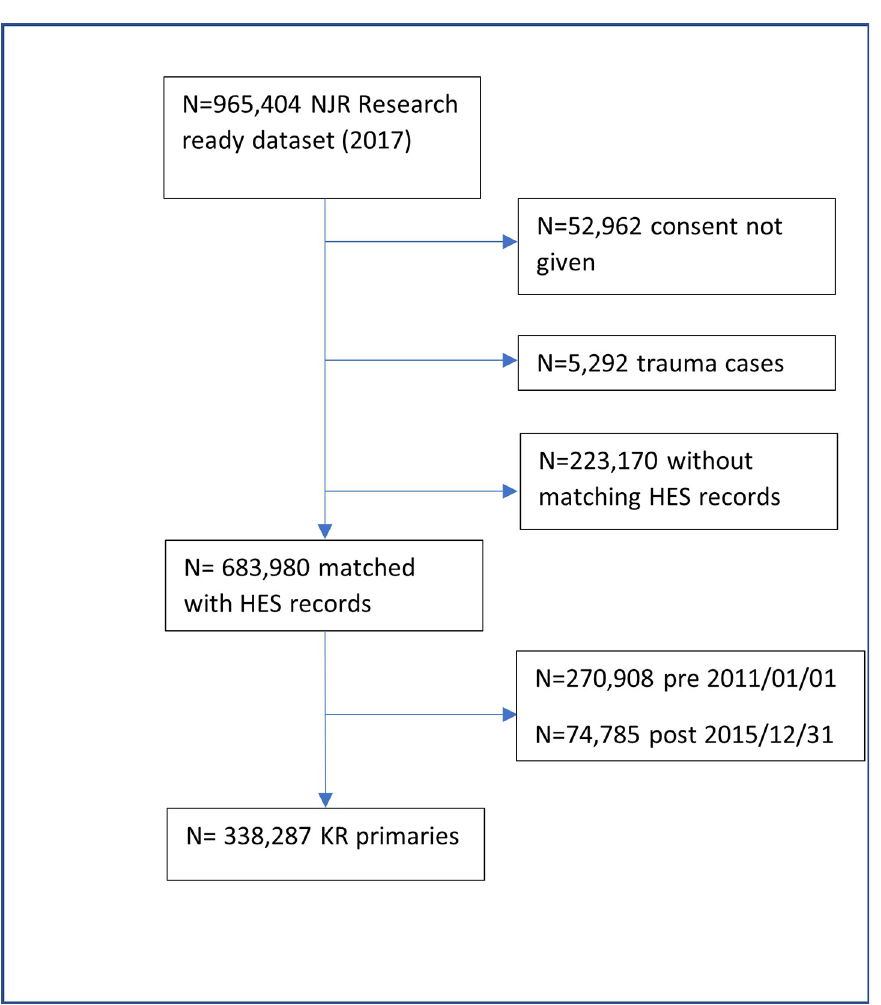
Fig 2. Flowchart of eligible primary